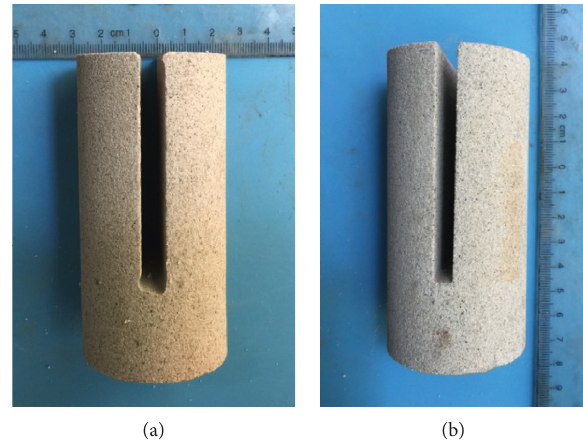
Figure 1: Prefabricated crack: 6 mm width and 75% length.